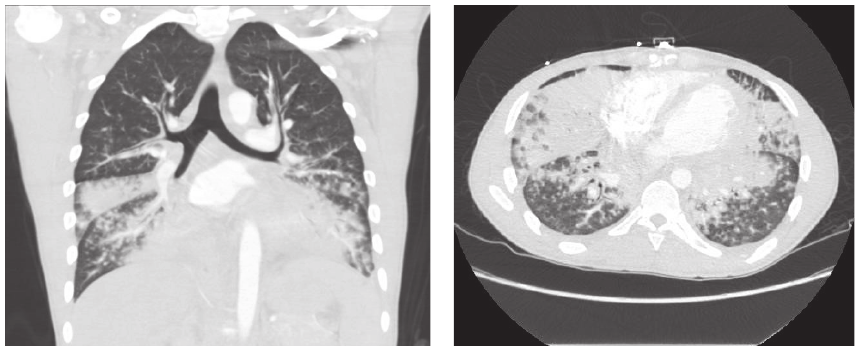
Figure 1: CT of chest with contrast: coronal and axial views showing fibronodular infiltrates with consolidation in the right middle and lower lobes and left upper and lower lobes.